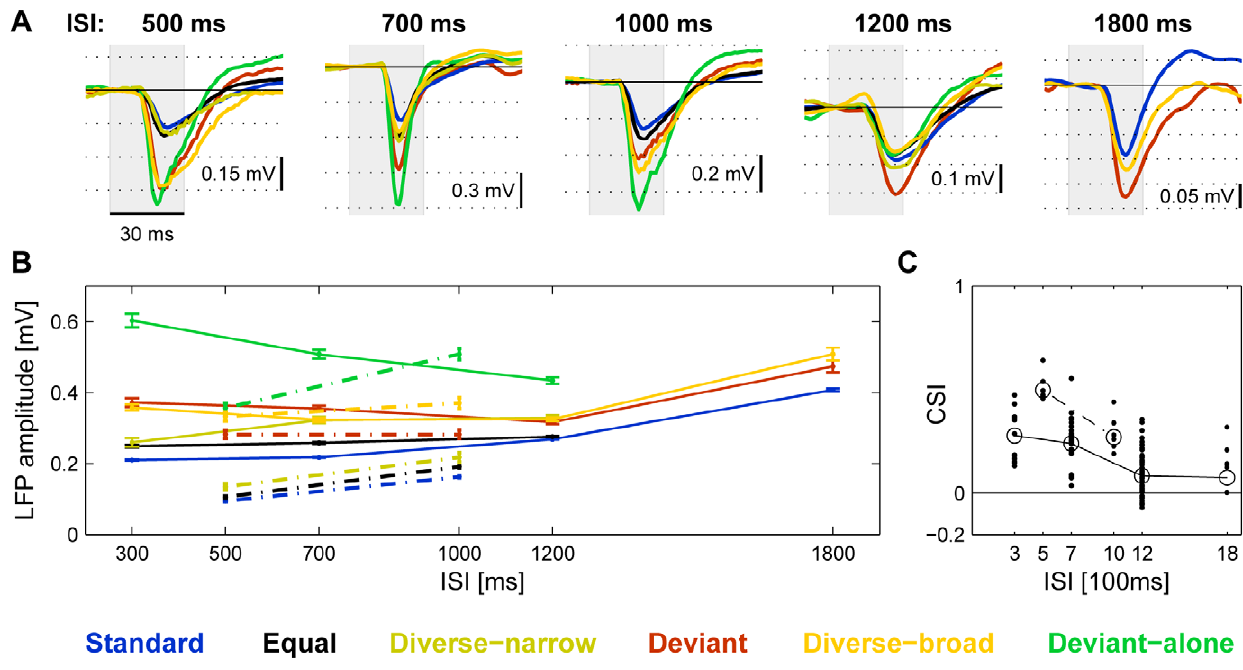
Figure 8. Respones as a function of ISI. A. Average LFP responses at five different ISIs. The examples, from different animals, show the responses to the low frequency (f1) in each pair. B. The population average of the responses to different ISIs for the two groups of rats (continuous and dashed lines) used in testing the effects of ISI. The error bars are s.e.m. For more details, see text. C. The distributions of the individual CSIs at each ISI. Circles are ‘common’ averages, computed as the sum of all numerators of contrasts in each ISI value, divided by sum of all denominators.